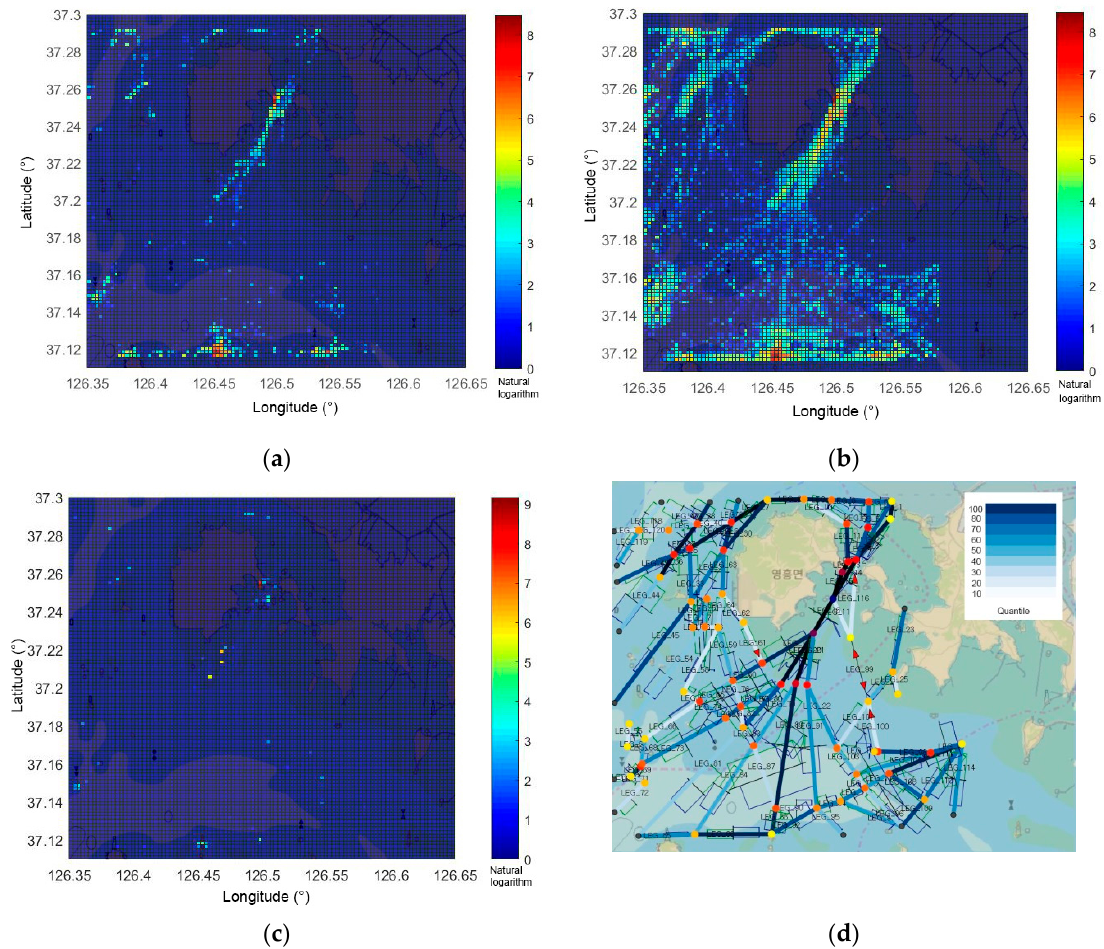
Figure 10. ( a ) Heat map of the alarm generation zone, ( b ) heat map with the PARK model risk value at or above five, ( c ) heat map with ES value at or over 750, and ( d ) results of the collision frequency estimation by IWRAP MkII.